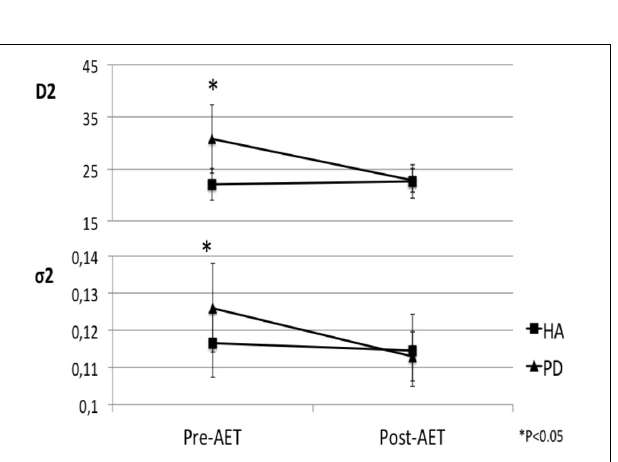
FIGURE 3 | Normalization of antagonist parameters in PD group after AET. AET, aerobic exercise training; PD, Parkinson’s disease patients, HA, healthy adults; D 2 , antagonist component; σ 2 , response spread of D 2